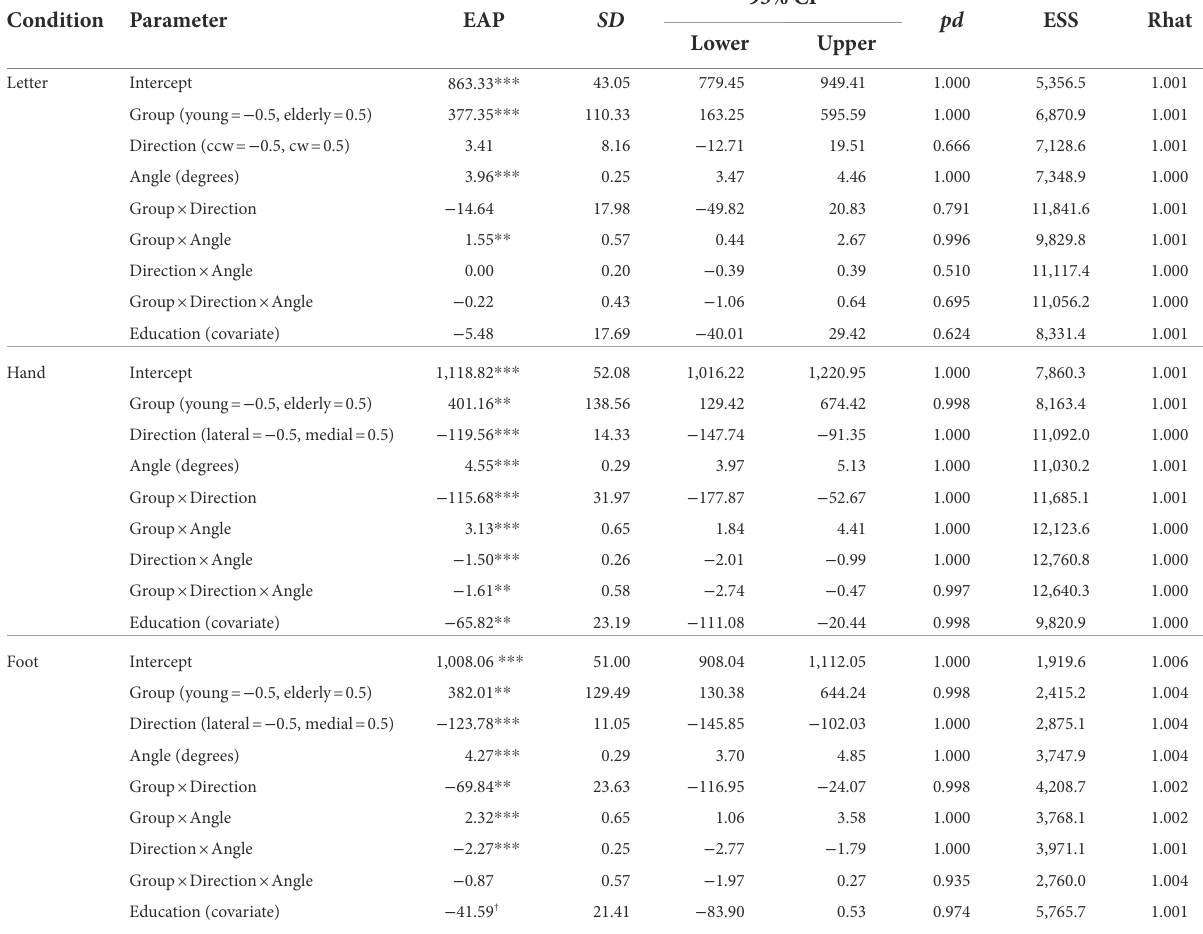
TABLE 1 Parameter estimates for comparison of the mental rotation Δ RT between the young group ( n = 28) and older groups ( n = 71).